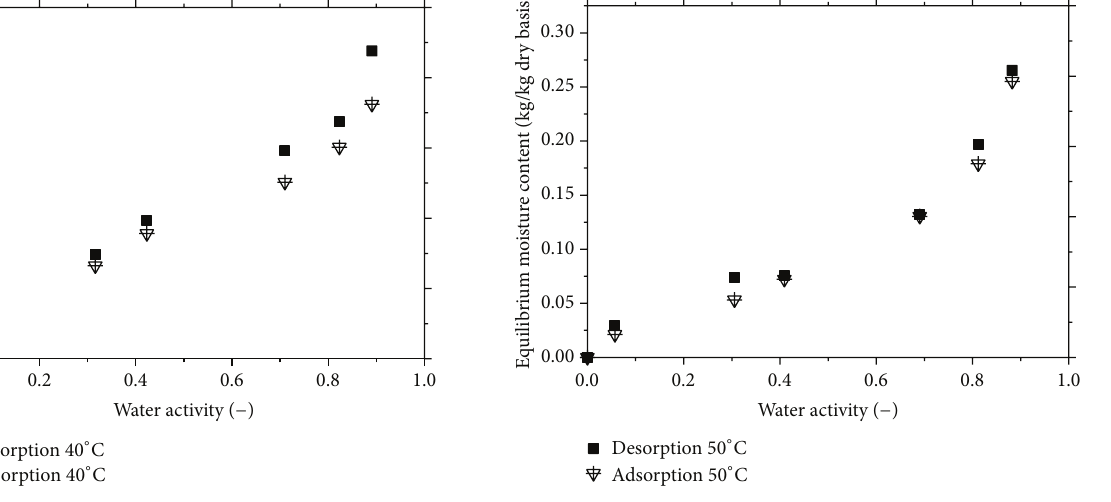
Figure 3: Desorption and adsorption isotherms of Ziziphus spina- christi leaves obtained at 50 ∘ C. Des: desorption; Ads: